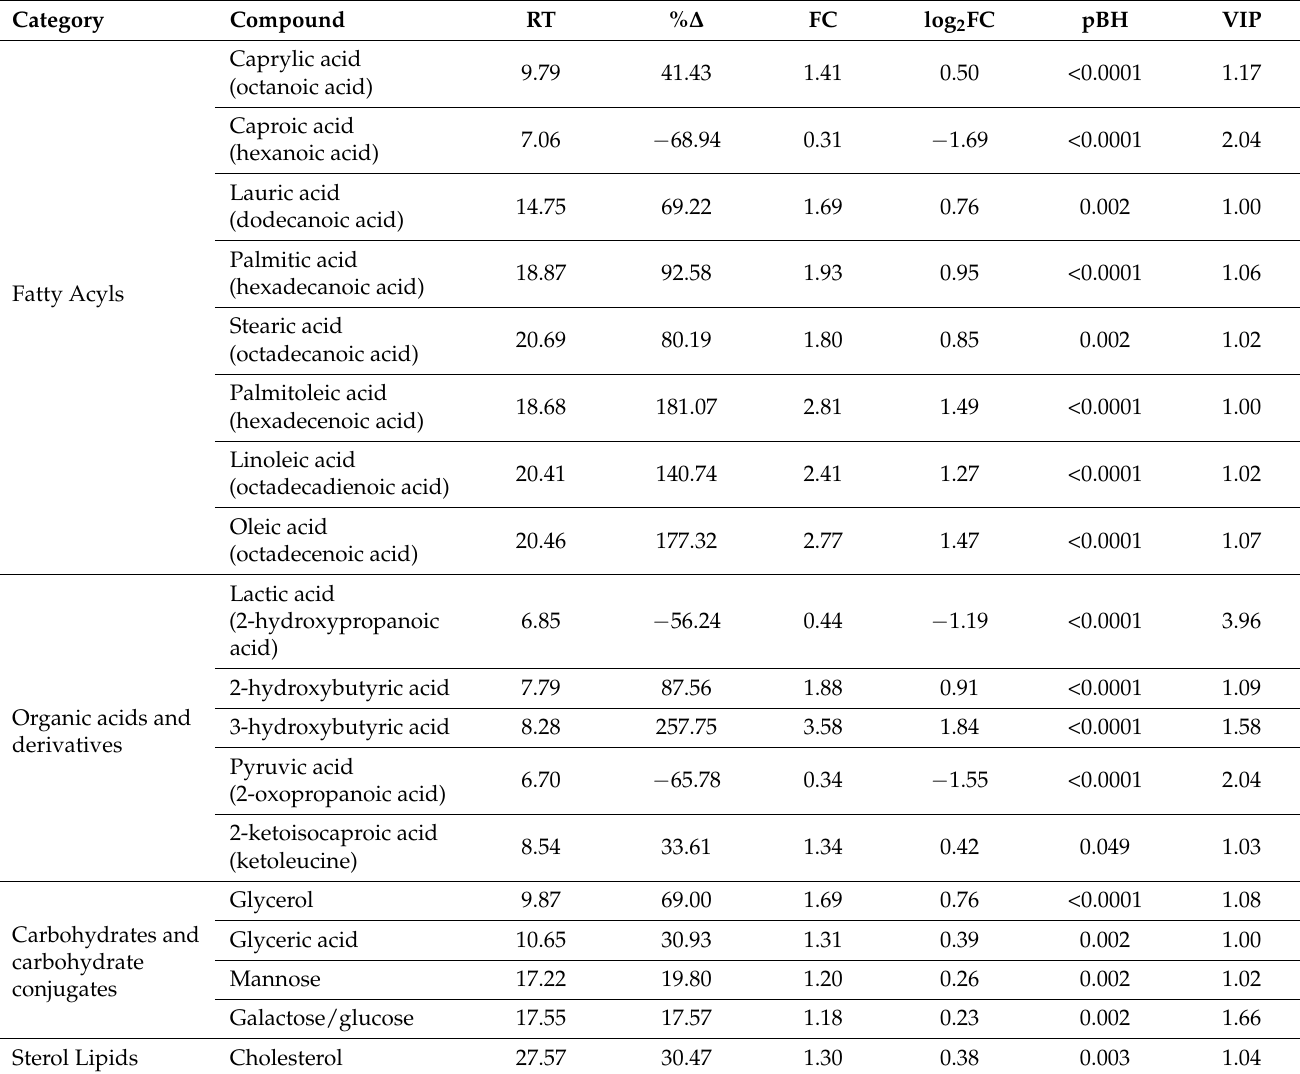
Table 1. Significantly altered metabolites, detected by GC-MS, between patients with prostate cancer and healthy control